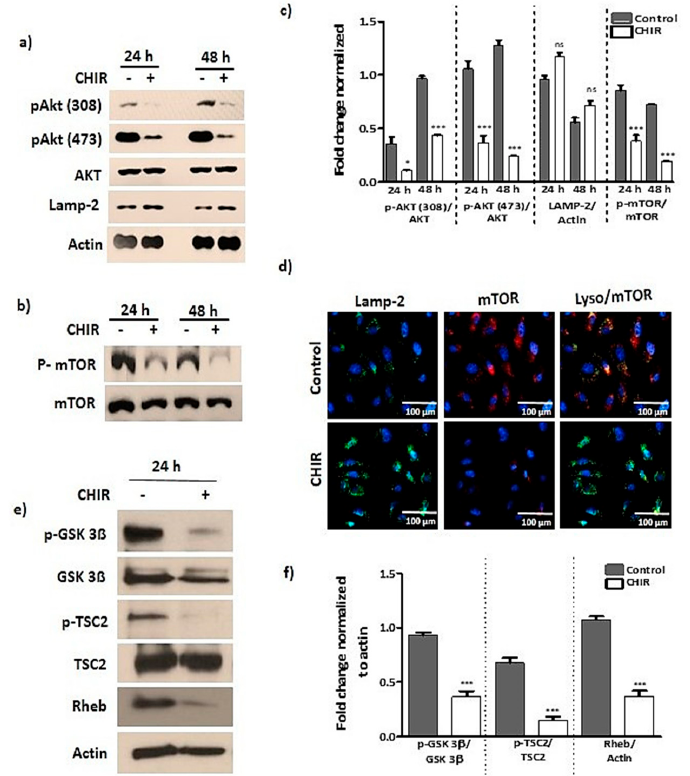
Figure 2. GSK-3 β inactivation by CHIR99021 treatment deregulates AKT and mTOR signaling. ( a – c ) Cells were treated with CHIR99021 (3 uM) for 24, 48 h, then Western blot was performed to detect the phosphorylation and total form of AKT, mTOR, Rheb, LAMP-2 and actin (taken as load-